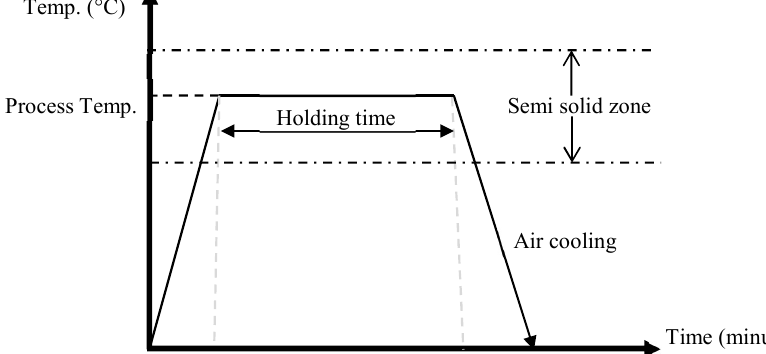
Figure 4. Temperature profile of direct partial remelting